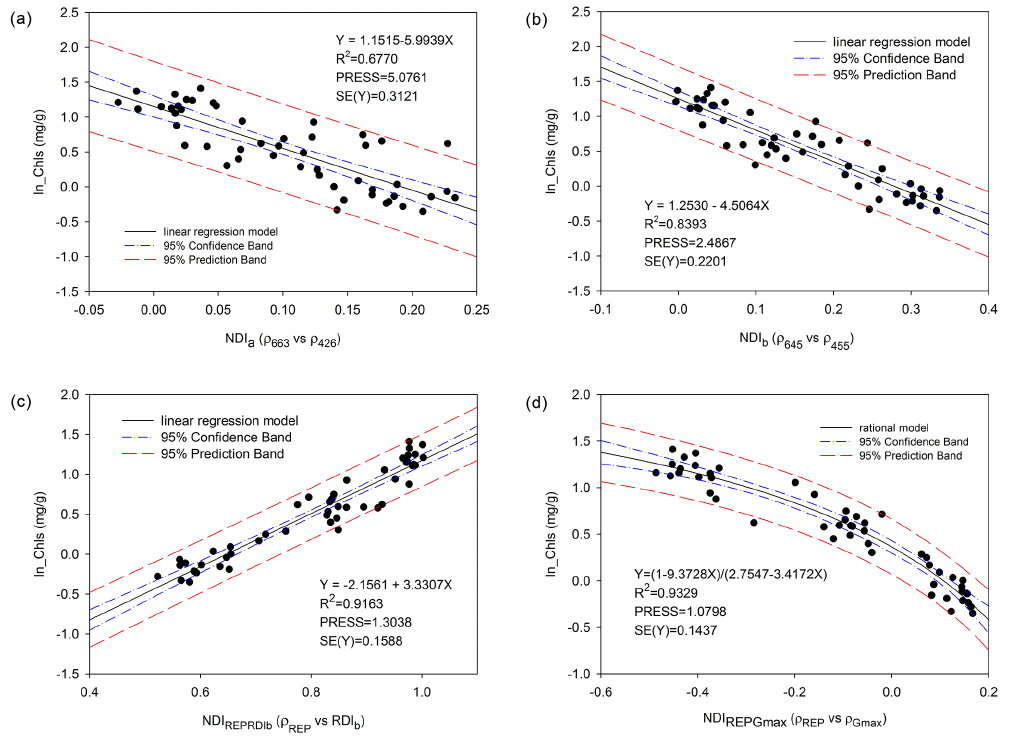
Figure 7. Normalized-difference-index-based empirical models for foliar Chls concentration